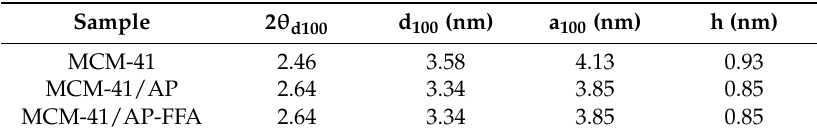
Table 2. Structural properties of the MCM-41 and functionalized samples calculated, from the positions of the (110) plane reflections.